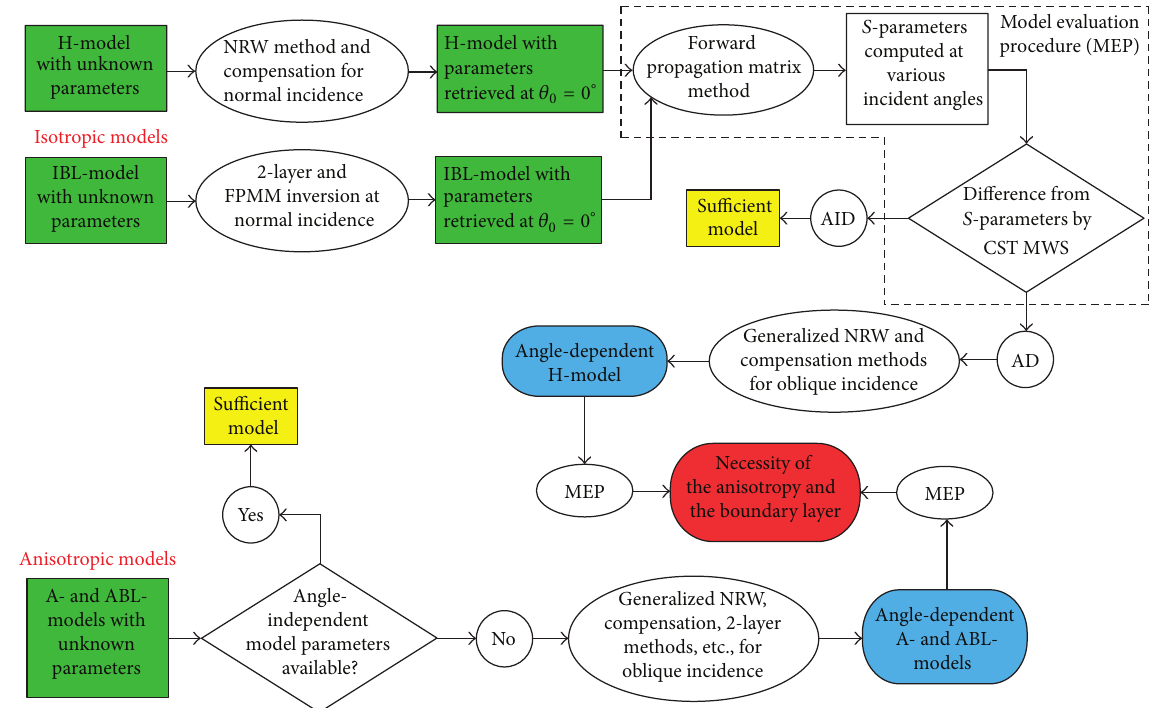
Figure 4: Flow chart as the skeleton of Section 4 where AD and AID stand for angle dependent and angle independent. The process in the dashedboxistermedasmodelevaluationprocedure(MEP),includingthe 𝑆 -parameterscomputationforaderivedmodelandthecomparison with the simulated 𝑆 -parameters from a real composite slab. The reason that the IBL-model is absent from the final comparison highlighted by the red box will be explained in Section 4.5. One can refer the model abbreviations to the definitions in Figure 2.